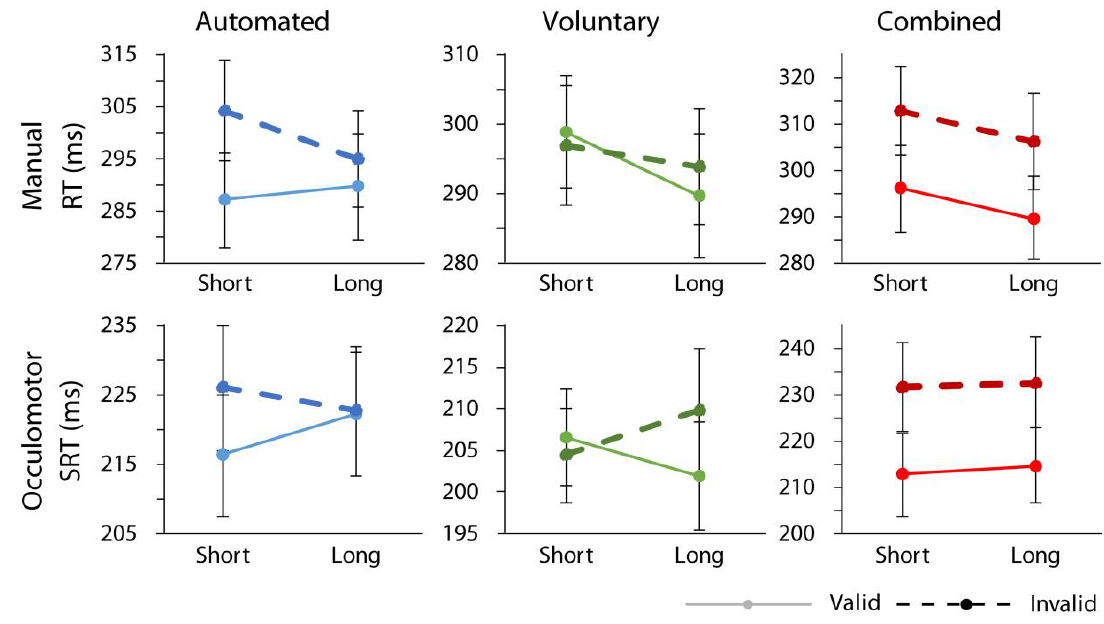
Figure 2. Response time data. Mean correct interparticipant response times plotted as a function of attention condition, response modality, cue-target time interval, and cue validity. Error bars indicate standard error of the difference between means.